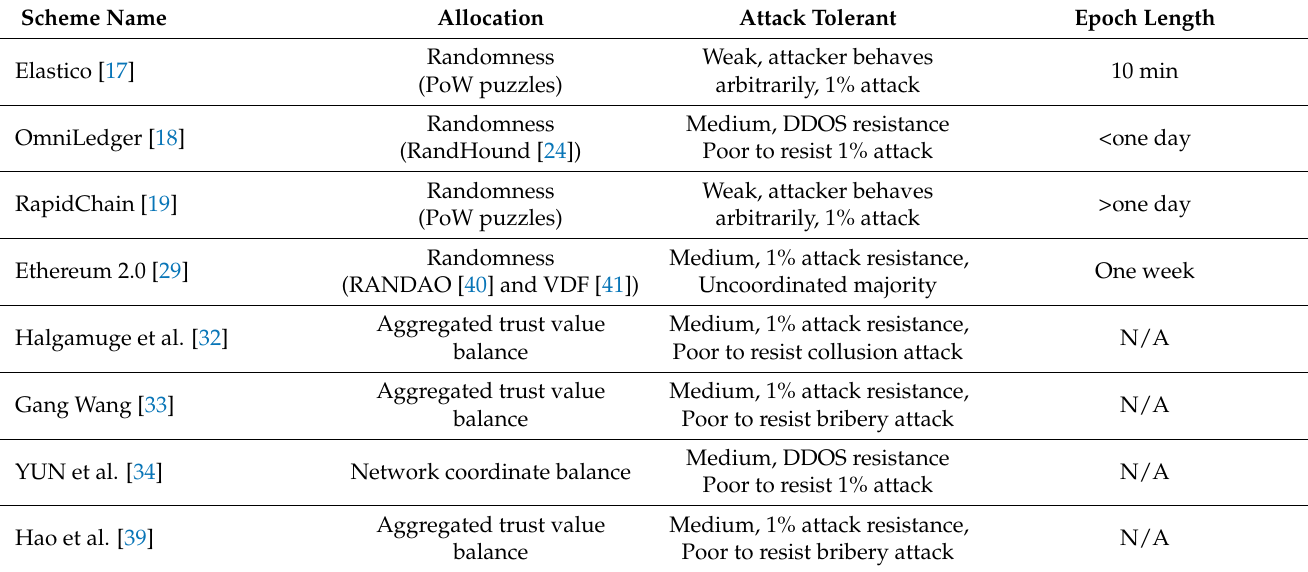
Table 1. Limitation overview of existing